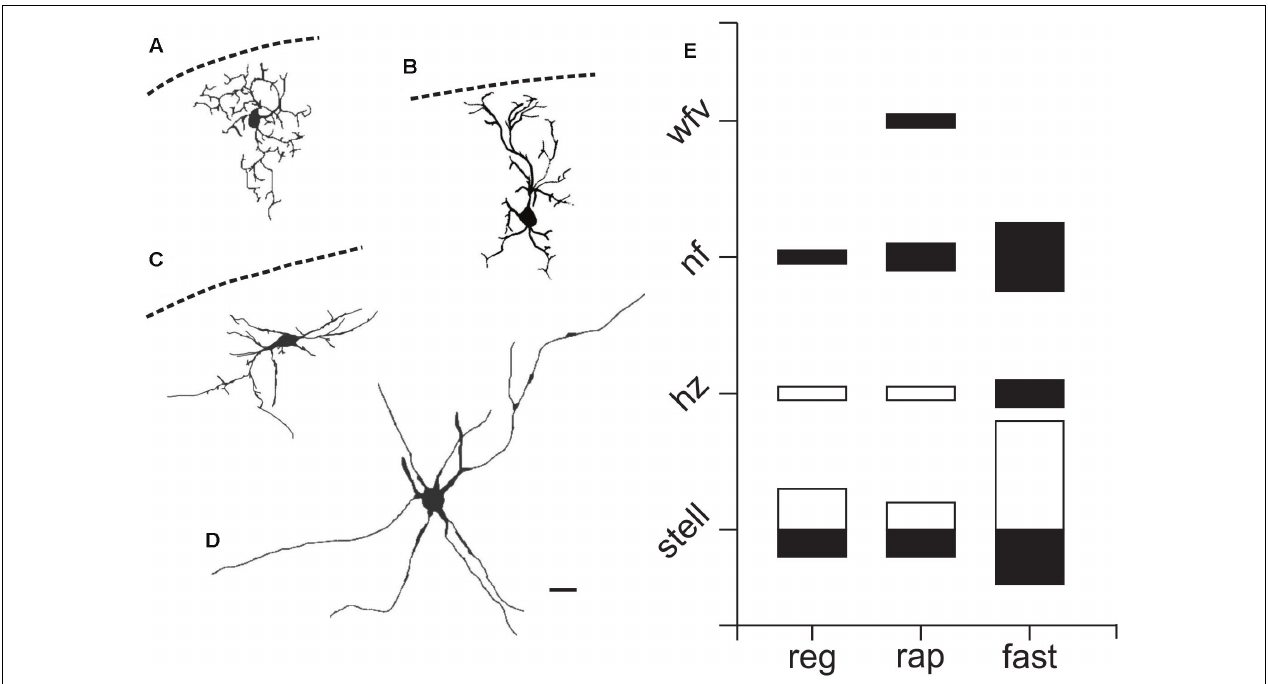
FIGURE 4 | PV + neurons in the SC show a variety of morphological properties. Drawings from visually identified PV + neurons filled with Lucifer yellow or biocytin in the SC from slices obtained from Ai9;PV-Cre mice. (A) sSC stellate. (B) sSC narrow field vertical. (C) sSC horizontal. (D) iSC radial stellate. Scale bar: 20 µ m. (E) Quantification of PV + neurons according to their morphology and electrophysiological features for both sSC (black) and iSC (white). The size of the squares indicates number of PV + neurons on each of the